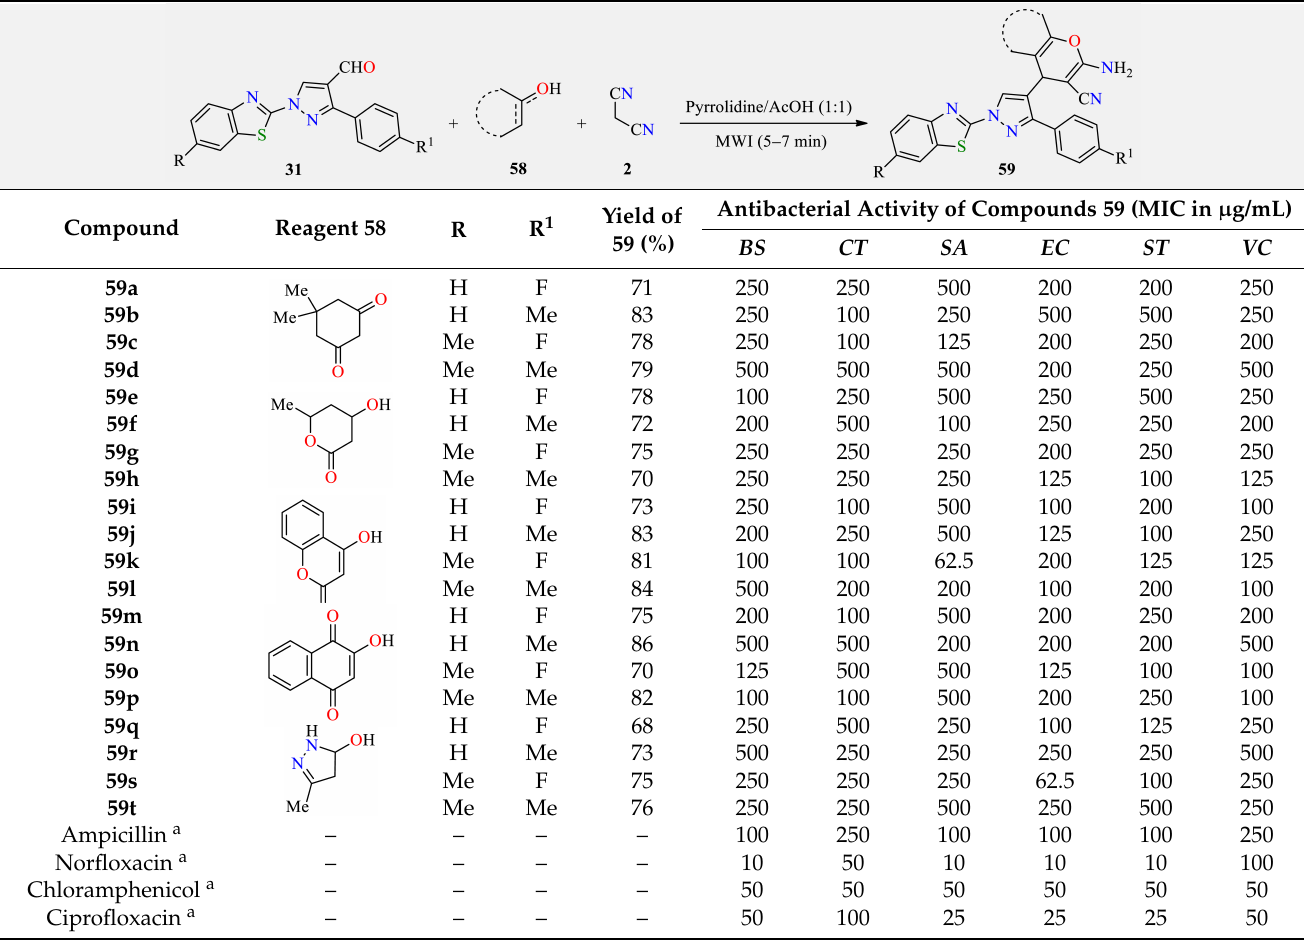
Table 16. Microwave-assisted three-component synthesis of pyrano-pyrazole derivatives 59 and their in vitro antibacterial activity evaluation against a panel of six pathogenic